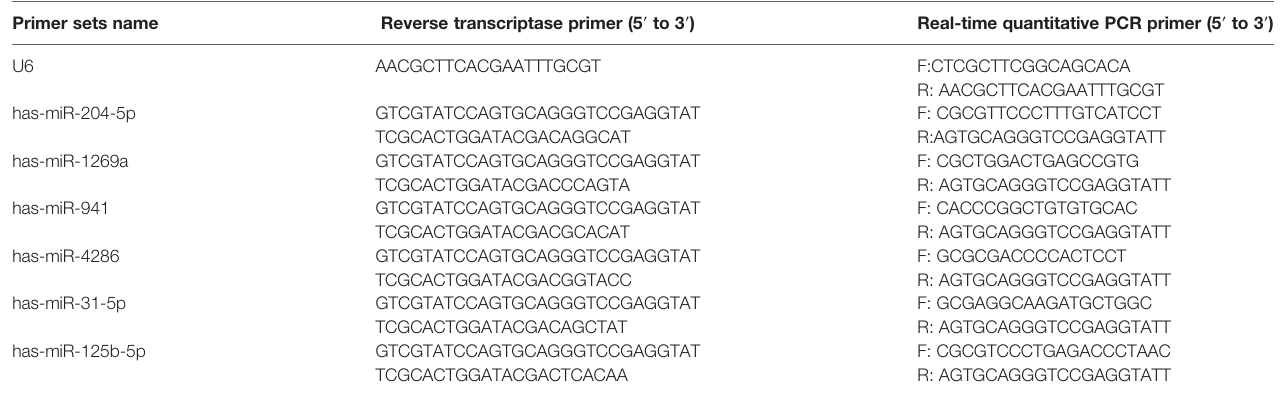
TABLE 3 | Oligonucleotides used in this